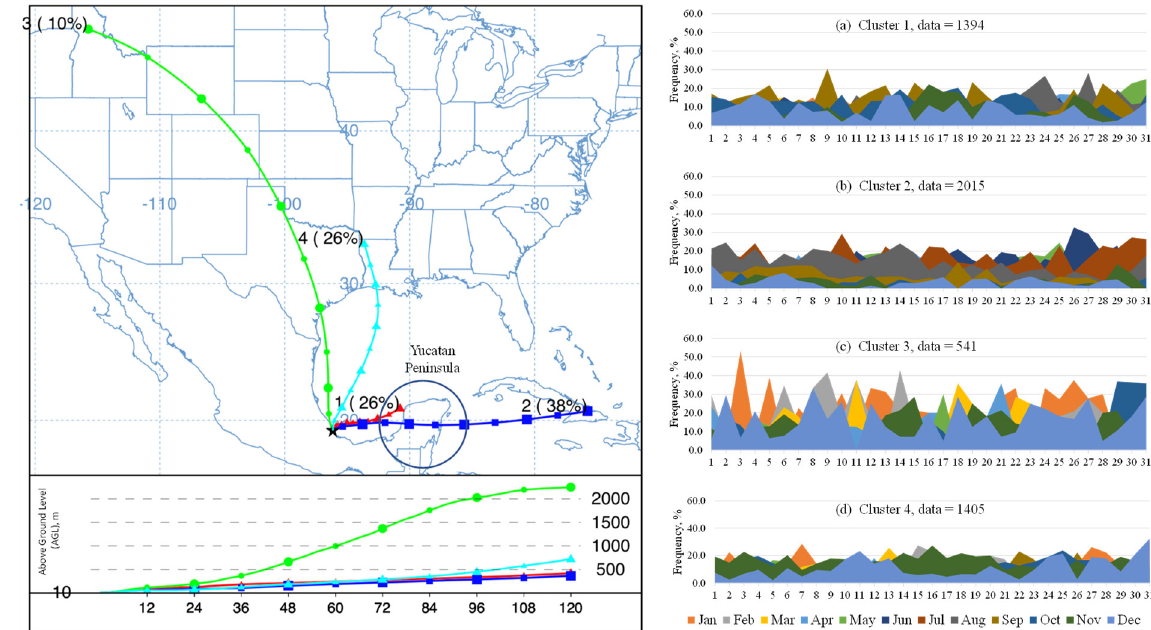
Figure 9. Backward trajectories from 2010 to 2020 and 120 h trajectory span.